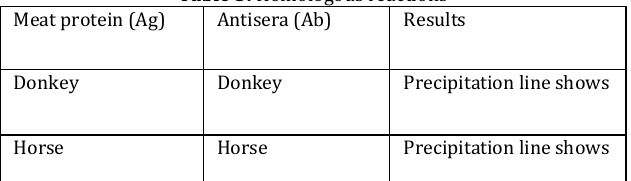
Table 3: Homologous reactions